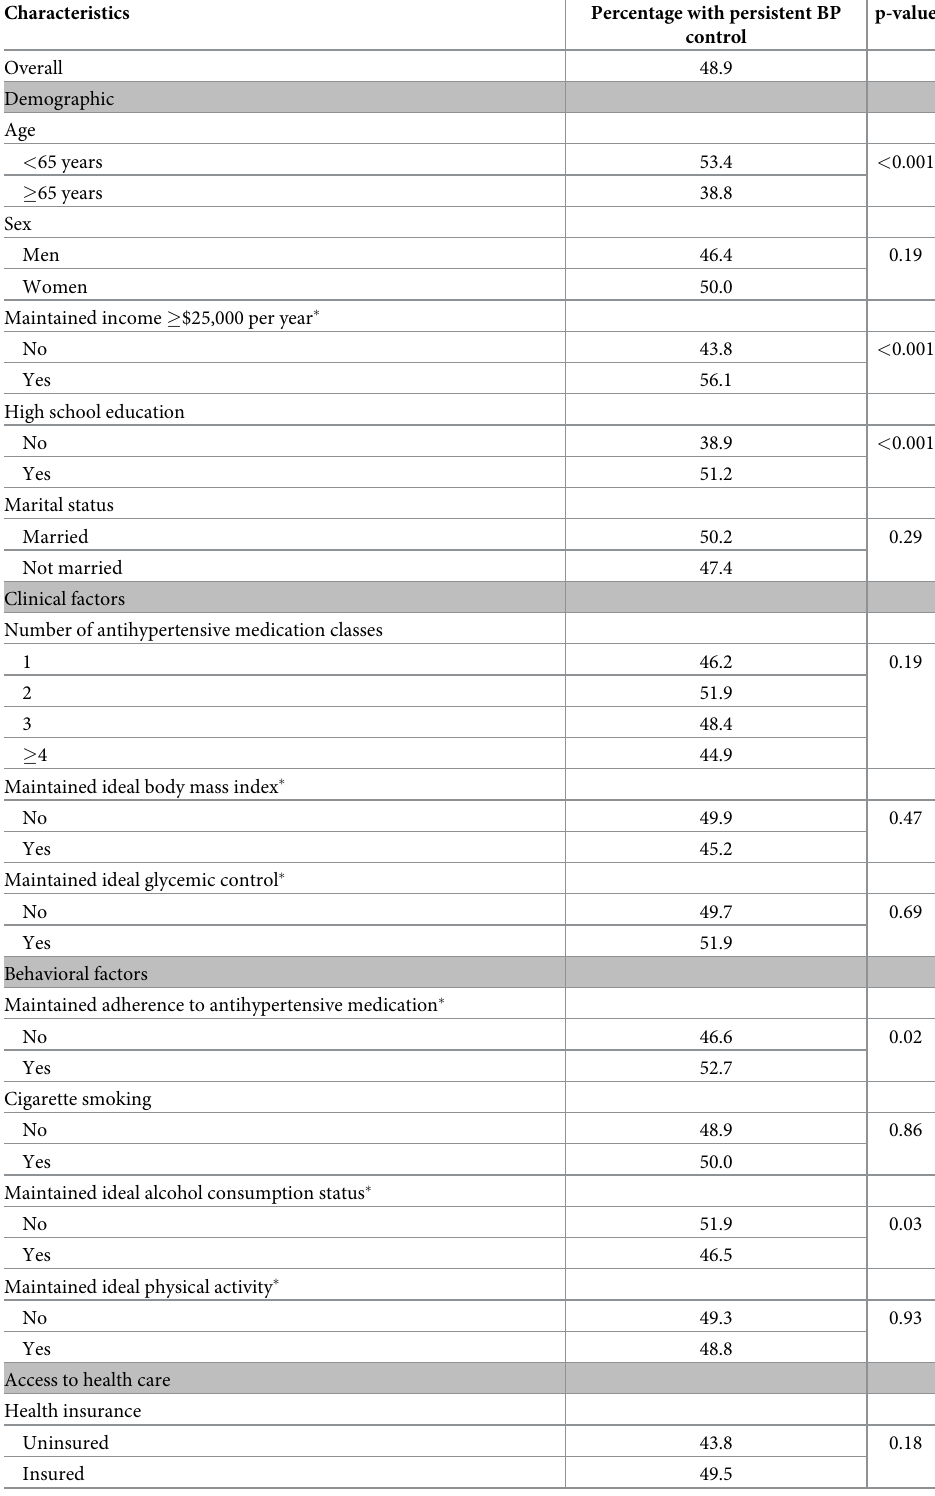
Table 2. Percentage of participants with persistent blood pressure control in